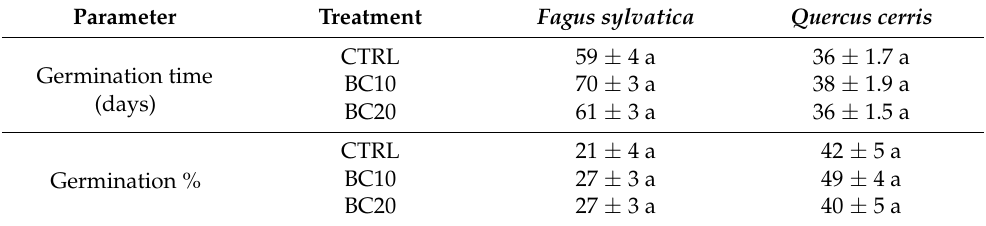
Table 1. Germination time and germination percentage (mean ± standard error) of seeds of Fagus sylvatica and Quercus cerris planted in soils amended with 0% (CTRL), 10% (BC10), and 20% (BC20) of BC; for each species, different letters indicate statistically significant differences between treatments ( p < 0.05).